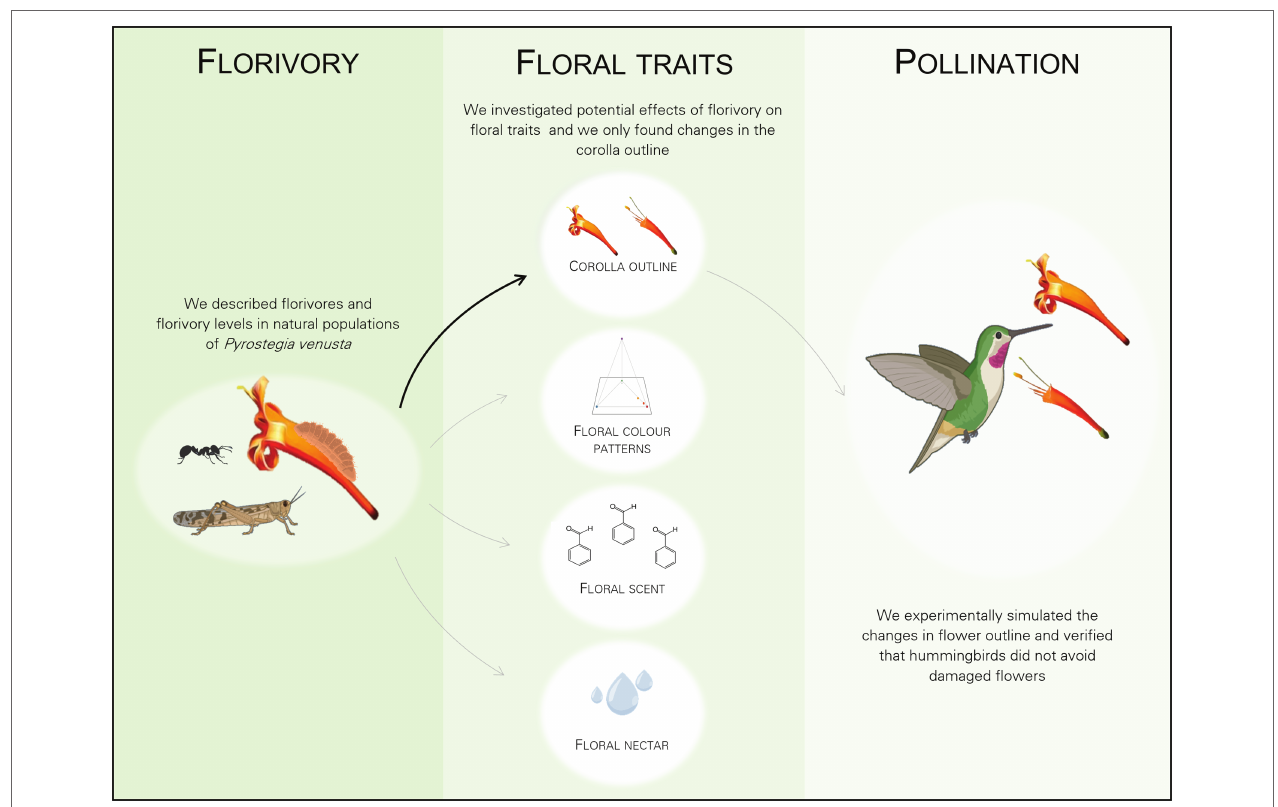
FIGURE 8 | Graphical summary of the experimental design of the study showing the general design and main results. Florivory, by the most common florivore, a Lycaenidae caterpillar, did not affect floral colour patterns, nor floral scent, nor floral nectar volume (grey arrows). Florivory only affected flower integrity, by changing the corolla outline due to the presence of damages per se (black arrow). Finally, we show that there was no effect of the mechanical simulation of floral damages on pollination (grey arrow). Created with